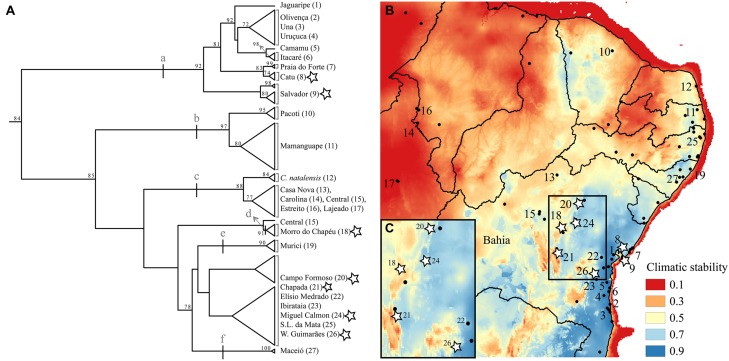
(A) mtDNA tree based on the 16S locus using maximum likelihood with bootstrapping. Support values equal or higher than 70 are shown. Letters (a-f) indicate clades described in the results. Names and numbers match the map of Northern Atlantic Forest climatic stability (B) over the last glacial cycle (∼120 kya to present-day; data from Carnaval et al., 2014). State lines are represented and the State of Bahia is labeled. Stars mark populations we sampled physiology data for. The insert (C) shows in detail climatic stability in the isolates (localities 18, 20, 21, and 24) as well as in one (out of the three) of the coastal localities also examined physiologically (8, 9, and 26).